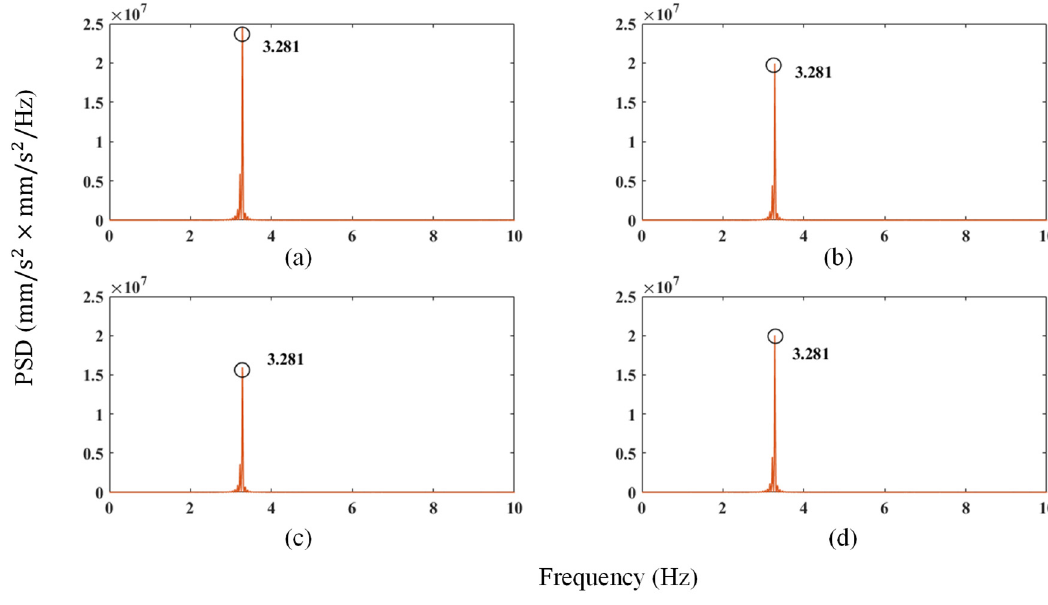
Figure 16. PSD curves of four cases: ( a ) fixed camera; ( b ) EMD; ( c ) FT; ( d ) DF.